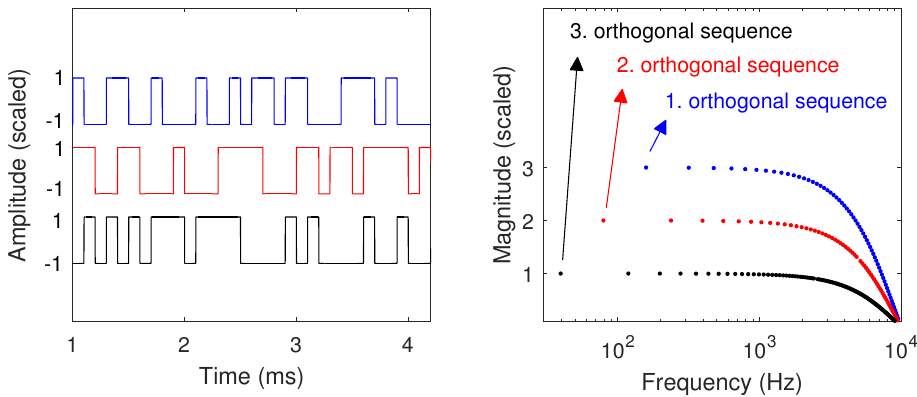
Figure 2. Three orthogonal binary sequences in the time and frequency